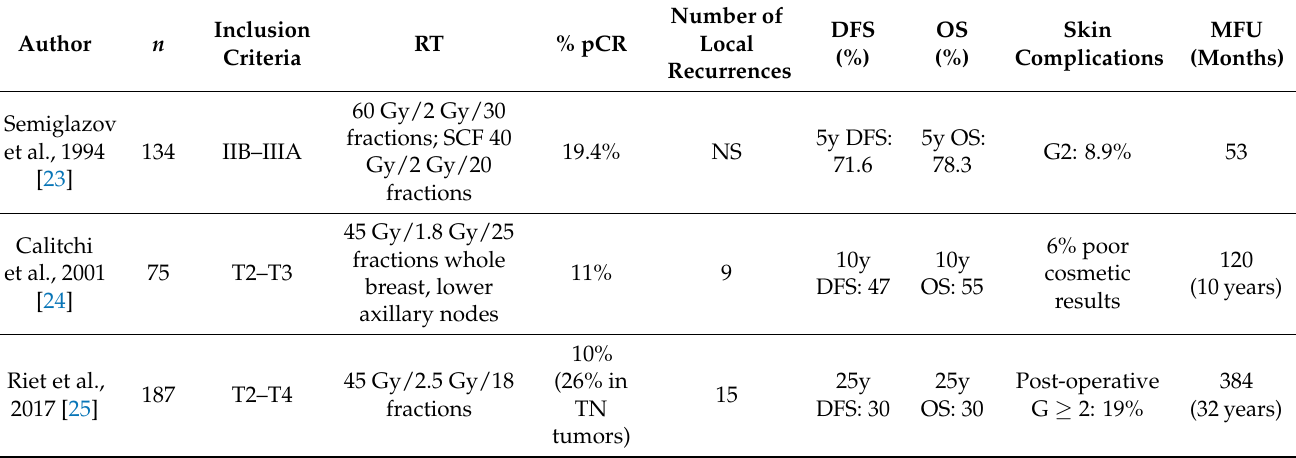
Table 1. Studies of preoperative radiotherapy in breast